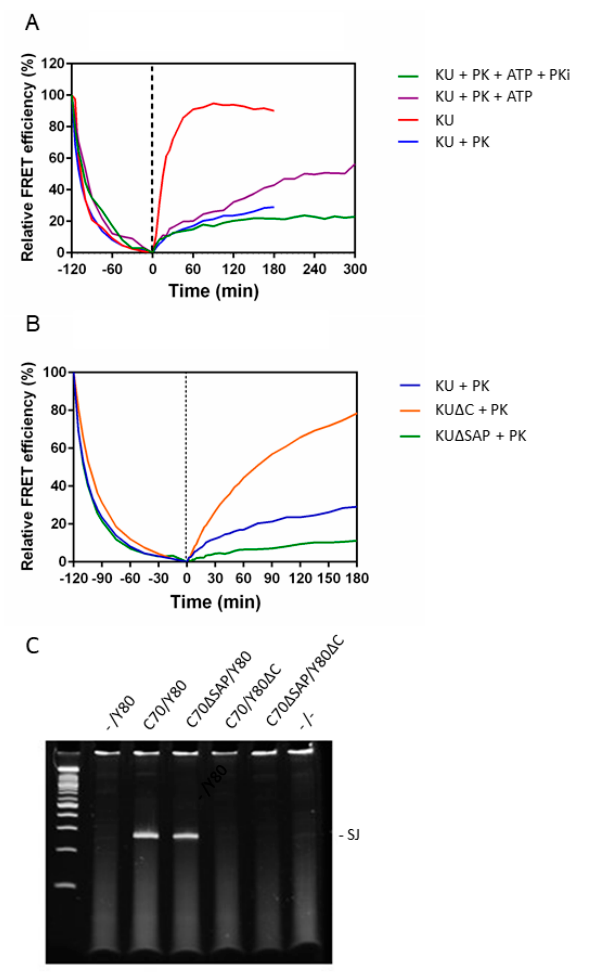
Figure 4. DNA-PK CS (DNA-dependent protein kinase) stabilized Ku binding to DNA ends. ( A ) ECFP-Ku70 / EYFP-Ku80 was incubated with DNA substrate bl1 in the presence or absence of DNA-PK CS (PK) with or without ATP and the DNA-PK inhibitor Wortmannin (PKi), as indicated. ( B ) ECFP-Ku70 / EYFP-Ku80 (KU), ECFP-Ku70 ∆ SAP / EYFP-Ku80 (KU ∆ SAP), or ECFP-Ku70 / EYFP-Ku80 ∆ C (KU ∆ C) were incubated with bl1 and DNA-PKcs. In ( A , B ), the salt concentration was 250 mM KCl; the relative FRET e ffi ciency was measured, and the excess untagged Ku70 / Ku80 protein was added at time point 0. ( C ) V(D)J recombination activity in Ku70 − / − / Ku80 − / − mouse embryonic fibroblasts complemented with ECFP-Ku70 (C70), EYFP-Ku80 (Y80), or mutants, as indicated. Signal joint (SJ) formation was tested by PCR amplification over the newly formed SJ.